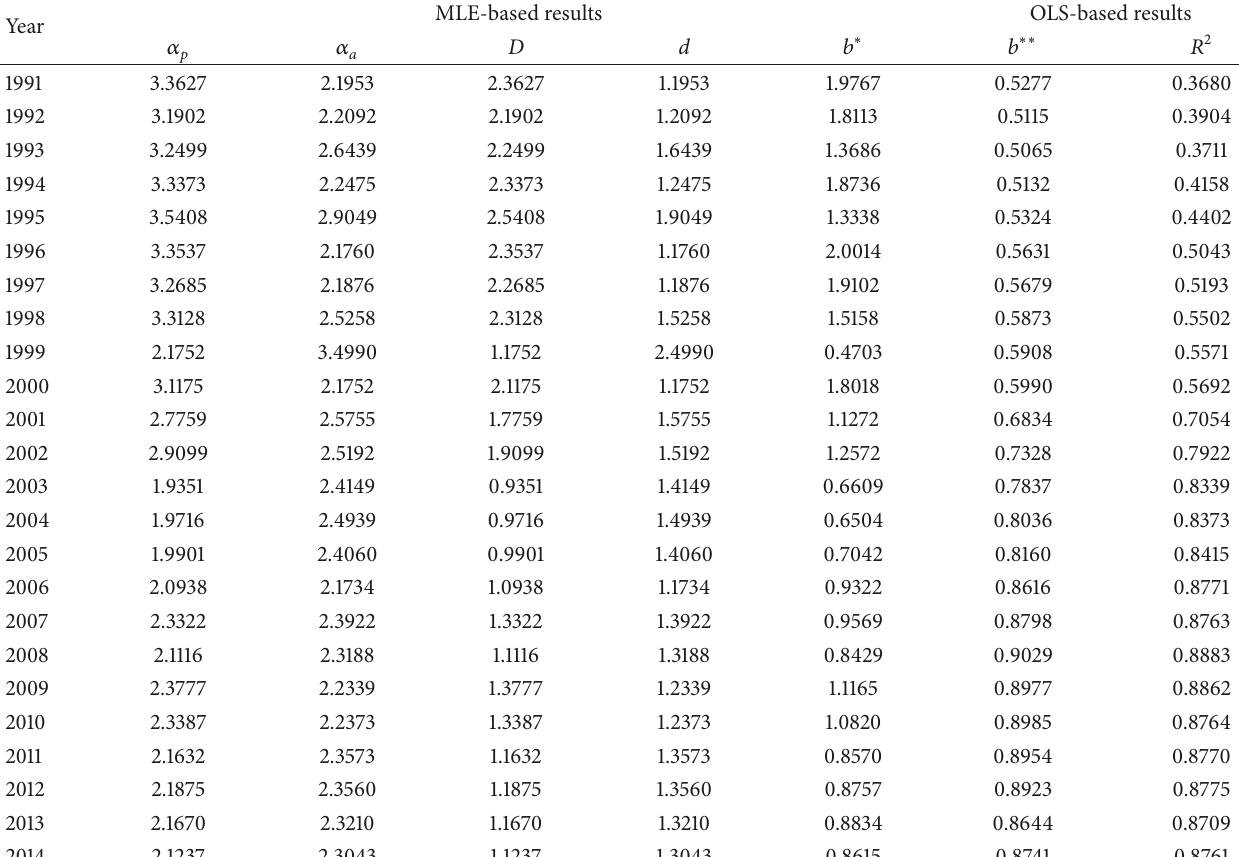
Table 5: A comparison between the allometric scaling exponents based on MLE and those based on OLS. Year